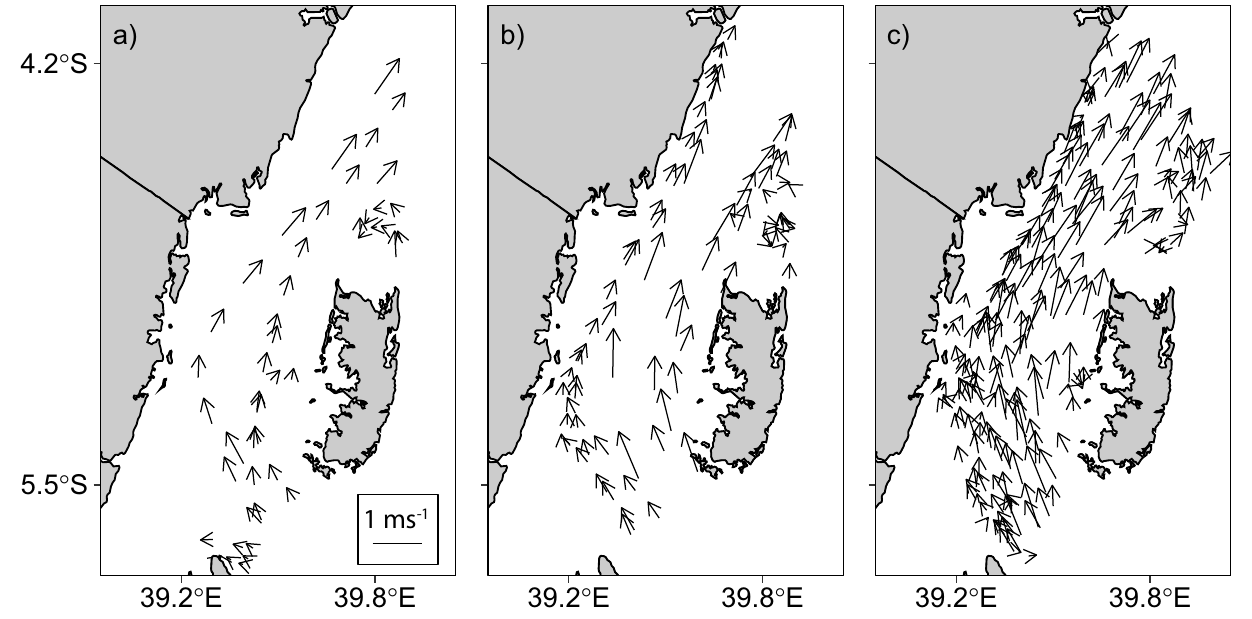
Fig 3. Vector field velocity of current speed and direction in the Pemba Channel during a) northeast (NE), b) inter-monsoon (IN) and c) southeast (SE) monsoon